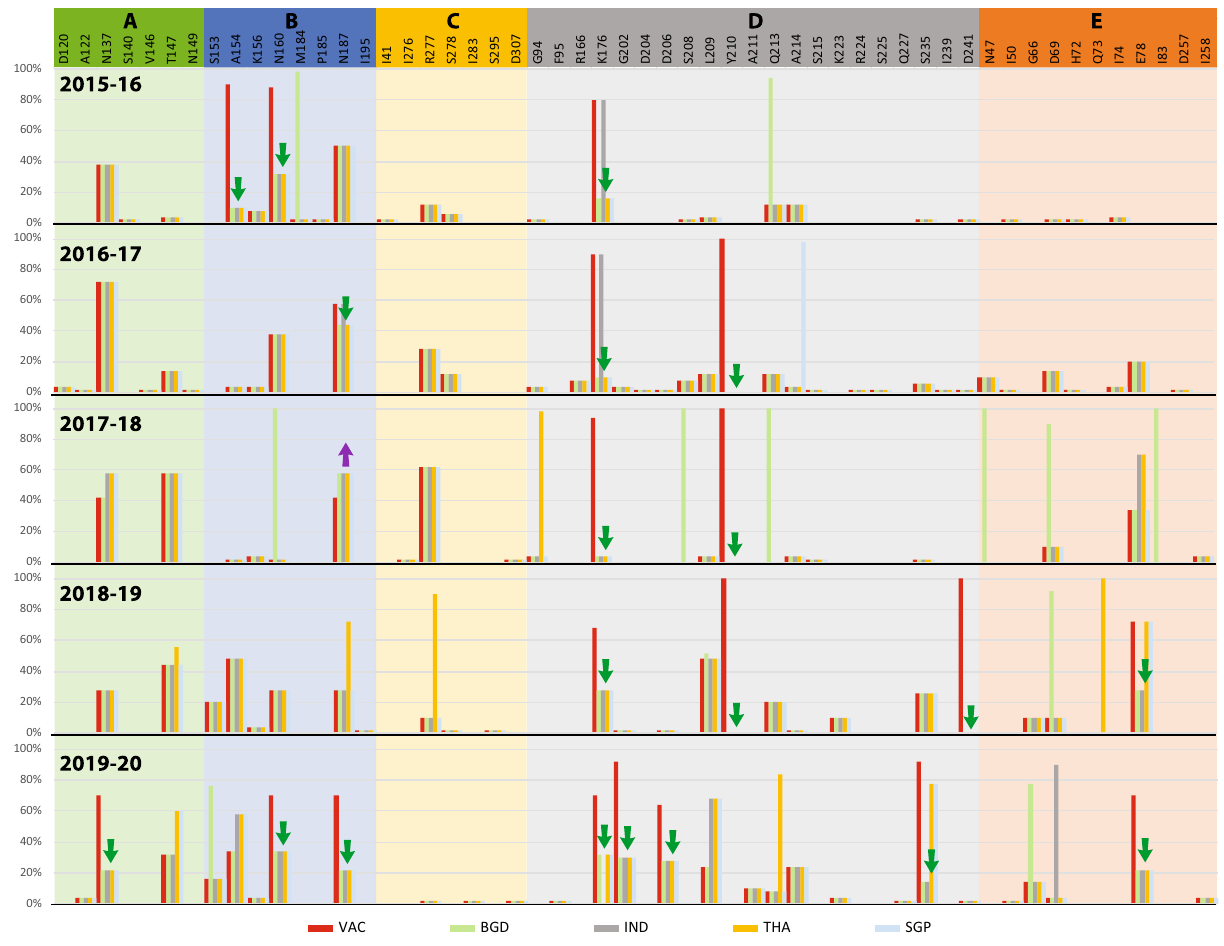
Figure 3. Amino acid changes in epitope site of global hemagglutinin protein (HA) sequences. The red bar indicates the percent of changes compared with the WHO-recommended vaccine, while others indicate p-vac. The green down-arrow indicates the site where p-vac (any of the four) showed higher proximity with global strains than the vaccine. The purple up-arrow indicates the site where the vaccine showed higher proximity than all p-vac.